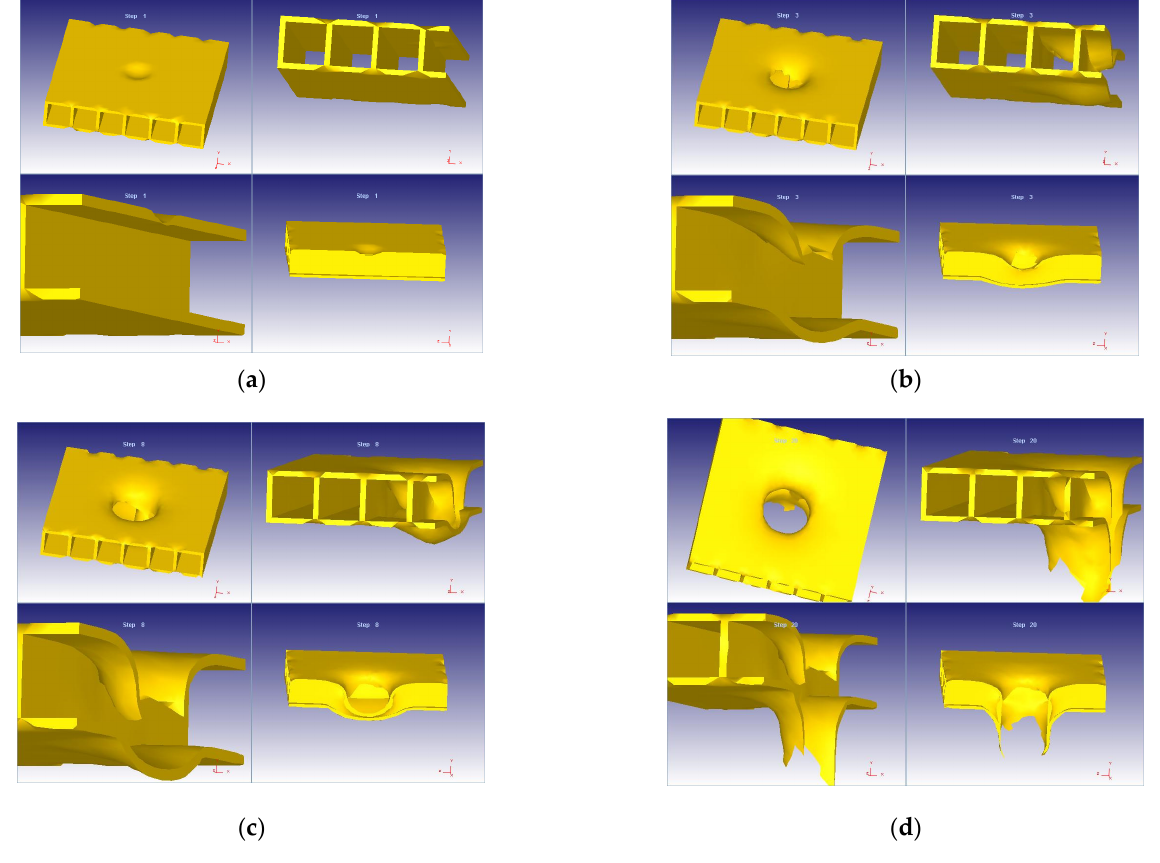
Figure 5. Impactor action. ( a ) Step 1. ( b ) Step 3. ( c ) Step 8. ( d ) Step 20.